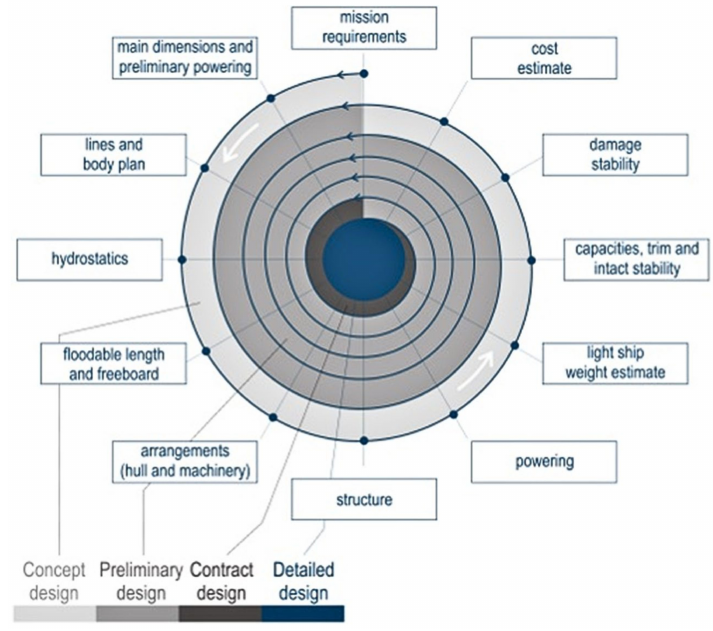
Figure 1. Traditional ship design as a spiral process.